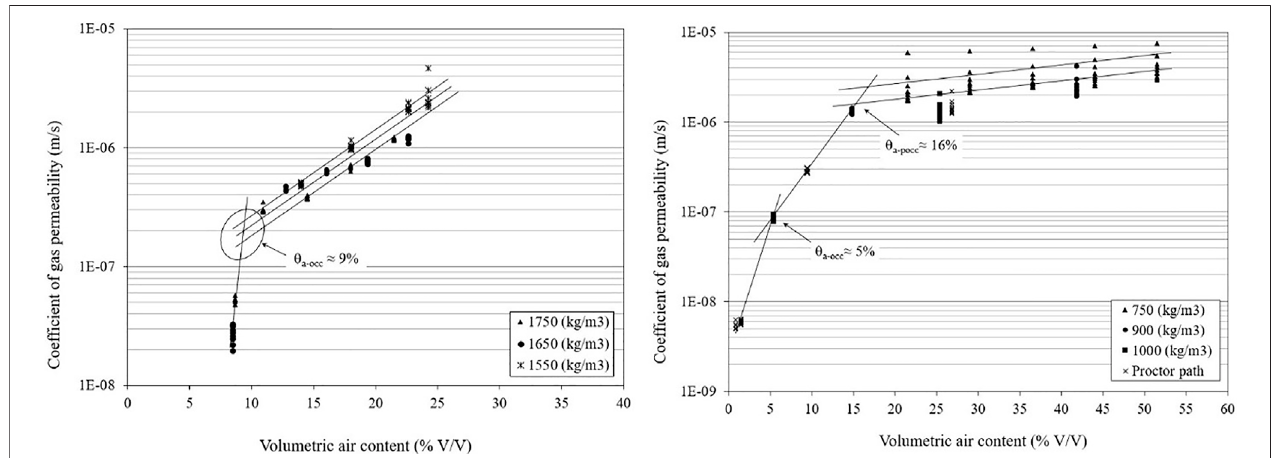
FIGURE 3 | Gas permeability function with volumetric air content (or air- fi lled porosity ε a ) adjusted by soil moisture: single drop ( fi ne sand, left) and dual-drop (compost-sand mixture, right). Fluid = air. Adapted from Ahoughalandari et al. (2018).